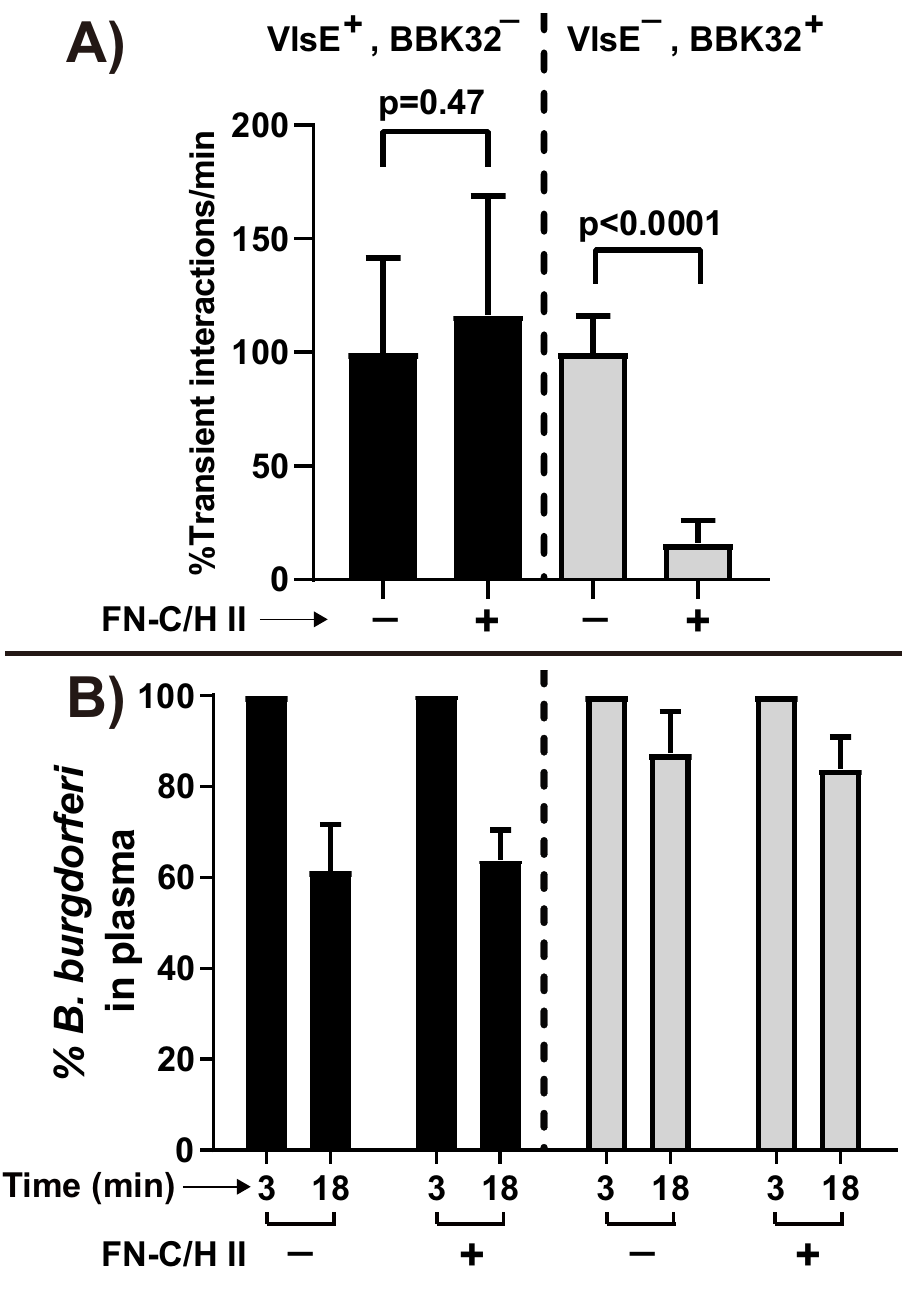
Fig 7. Intravital imaging to investigate the effect of the fibronectin heparin-binding peptide (FN-C/H II) on microvascular interactions in a VlsE gain of function strain (see Table 1 for strain info). A) Transient interaction rates in the knee joint were enumerated for two GFP-expressing B. burgdorferi strains : VlsE gain of function strain (GCB3023: VlsE + , BBK32 - ) and the control VlsE deficient strain (GCB4043: VlsE - , BBK32 + ) in mice treated or untreated with the FN heparin-binding peptide (FN-C/H II), as analyzed by high acquisition rate spinning disk confocal intravital microscopy. B . burgdorferi strains were prepared and injected as described in Materials and Methods, together with 100 μ g of FN-C/H II peptide as [11]. The data are plotted as the percentage of transient interaction/min observed in mice treated with FN-C/H II relative to the untreated mice for each strain. Error bars represent SD and statistical significance was analyzed using the non-parametric Mann-Whitney test (n = 4 mice). B) Clearance of B . burgdorferi from the vasculatures in the infected mice used in panel A was monitored with the same method as in Fig